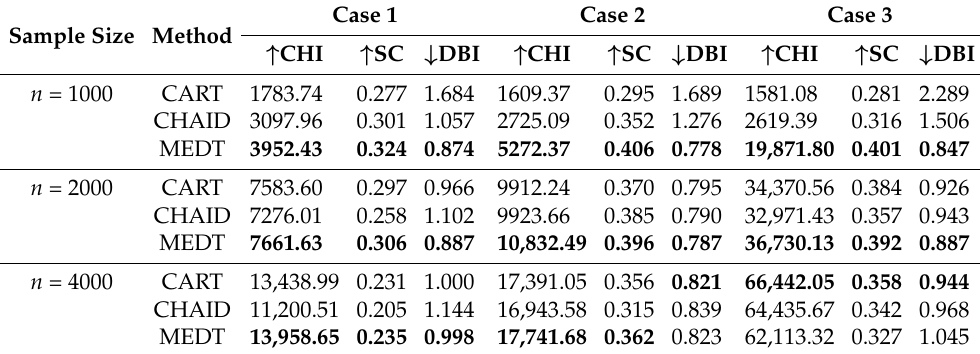
Table 1. Comparison of CART, CHAID, and the proposed method. The best result is in boldface. The up or down arrow indicates the higher or lower metric corresponds to the better